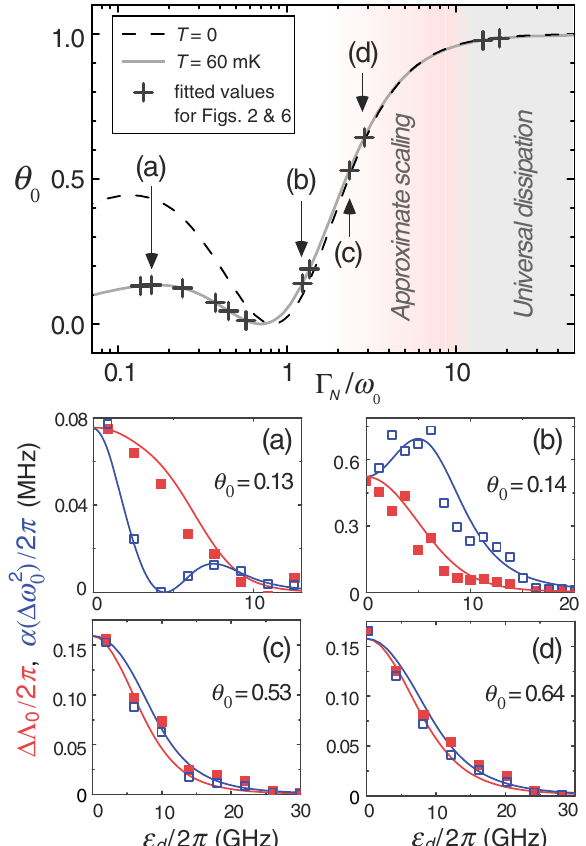
0 Þ versus the tunnel rate FIG. 3. Top panel: Ratio θ 0 ¼ θ ð ε d ¼ Γ , calculated from Eqs. (5), (8), and (B16) for T ¼ 0 (black N dashed line) and T ¼ 60 mK (gray solid line). The crosses correspond to fitted values of θ 0 , calculated from Eqs. (5) and (8) for the different resonances in Figs. 2 and 7. Bottom panels: Comparison between the experimental Δ Λ 0 and ð Δ ω 0 Þ 2 , using the scaling factor α ¼ πω 0 = 2 θ 0 g 2 , with θ 0 indicated with arrows = ω 0 ¼ 0 . 16 , 1.23, 2.33, and 2.86 from in the top panel. We use Γ N left to right and top to bottom panels. We also show, as blue and red solid lines, the calculated Δ Λ 0 and ð Δ ω 0 Þ 2 2 should be closely satisfied in the gray area Δ Λ Δ ω 0 and ð 0 Þ where θ 0 ≃ 1 . However, for the two resonances we have found in this area ( Γ ¼ 18 . 1 ω 0 and Γ ¼ 14 . 3 ω 0 ), we N N